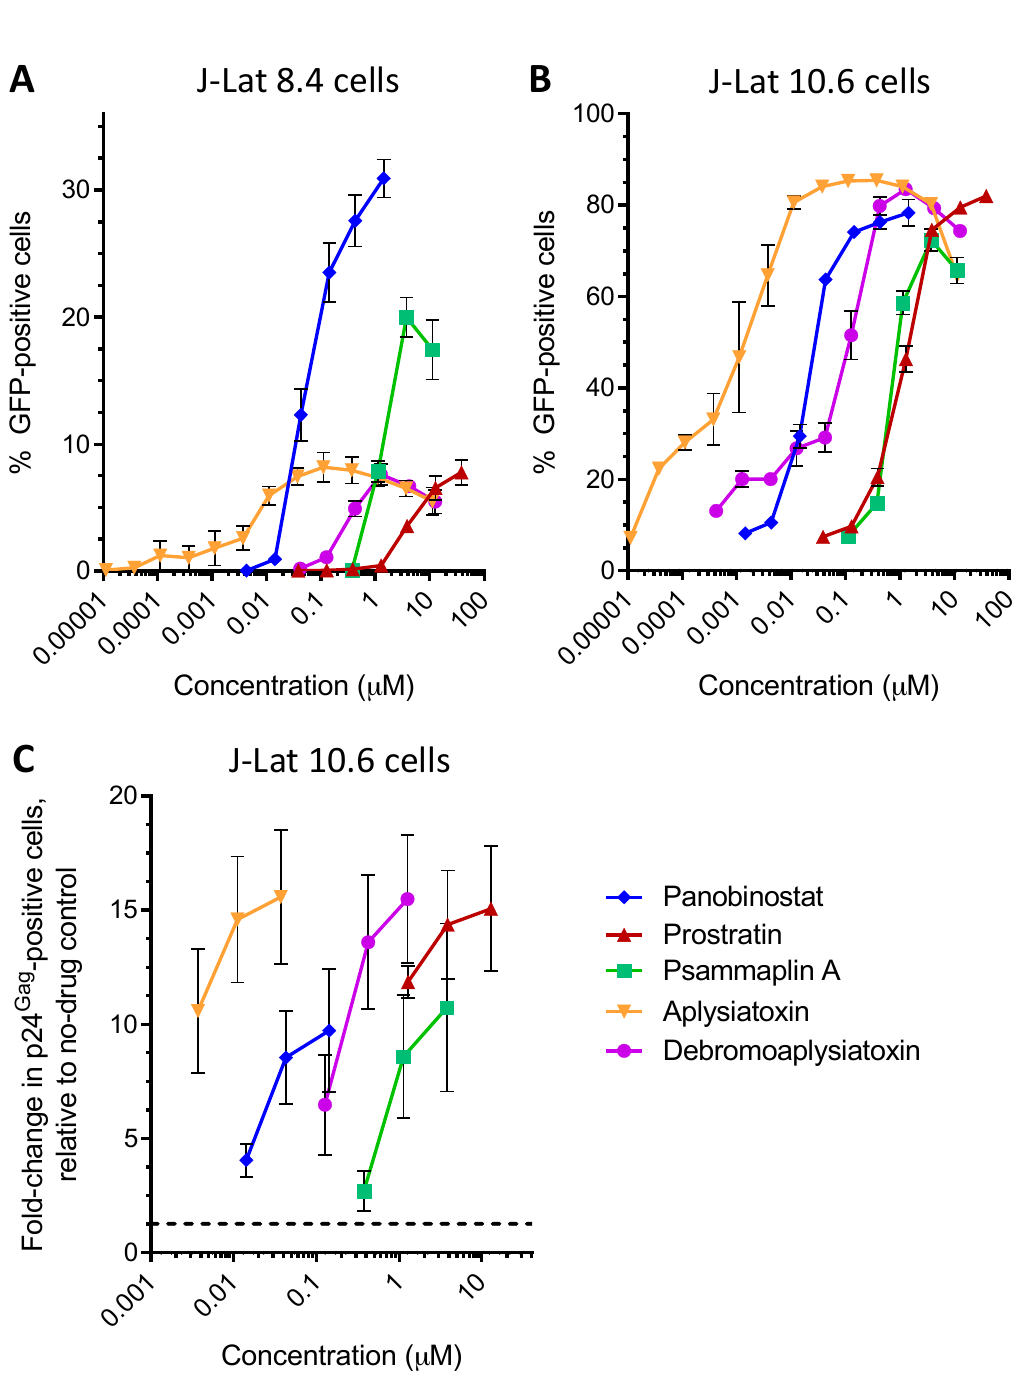
Figure 3. Natural products reverse latency in multiple cell line models. ( A , B ) Effects of LRAs on GFP expression in J-Lat 8.4 ( A ) and 10.6 cells ( B ). ( C ) Effects of LRAs on intracellular viral p24 Gag expression in J-Lat 10.6 cells. Data are presented as fold-change in supernatant p24 Gag relative to cells treated with 0.1% DMSO vehicle control (dotted line).